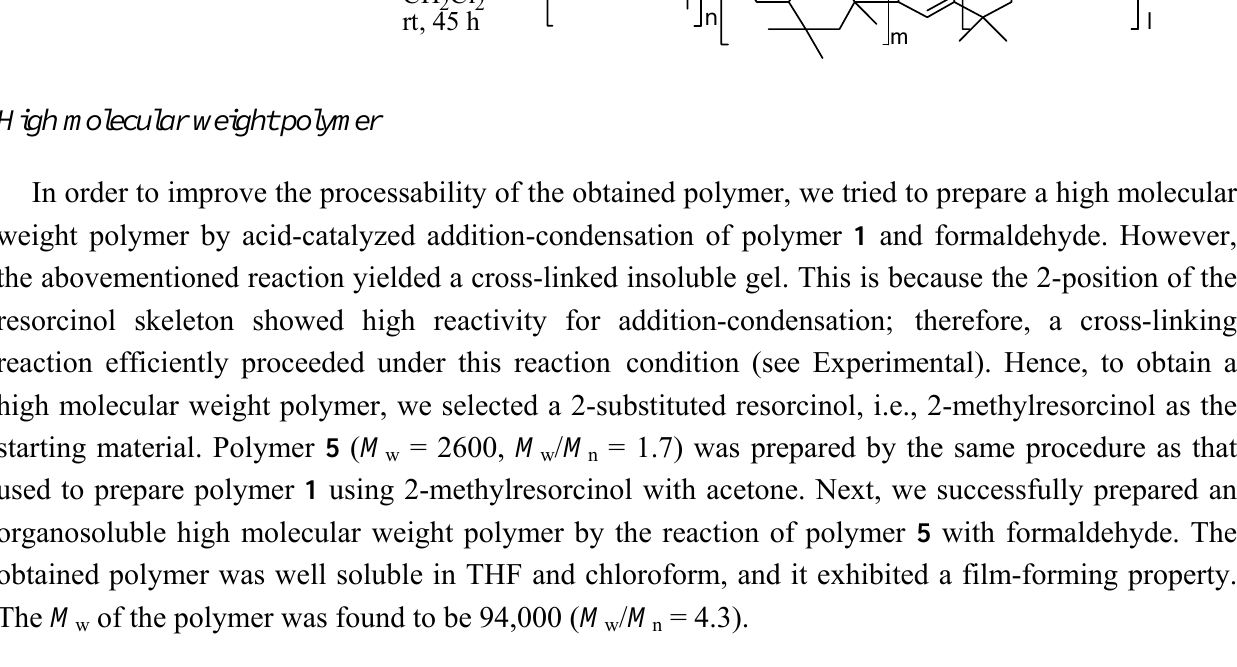
Scheme 3 . Synthesis of high molecular weight polymer 6 .